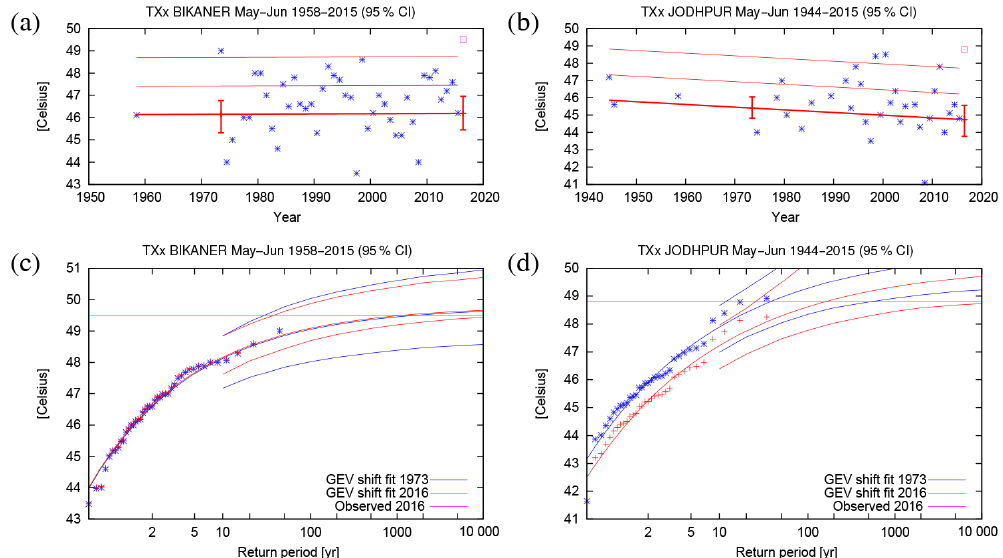
Figure 6. (a) Observed TXx at Bikaner, Rajasthan, India (GHCN-D v3.22) with a GEV that shifts with time fitted (excluding 2016), de- manding 70% valid data in May–June. The thick line denotes µ and the thin lines µ + σ and µ + 2 σ . (b) Same for Jodhpur. (c) Gumbel plot of the fit in 1973 and in 2016 (central lines). The upper and lower lines denote the 95% confidence interval. The observations are shown twice, shifted up and down with the fitted trend. (d) Same for